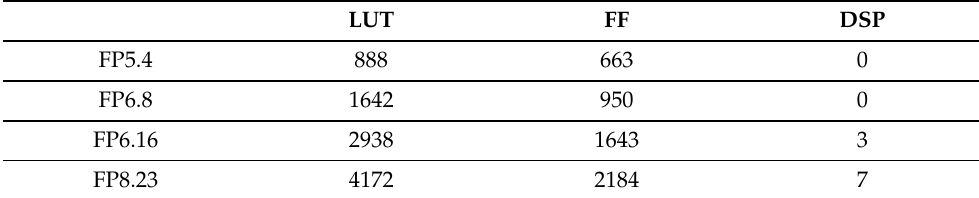
Table 4. Logic resources requirement for implementation of one ACSOM neuron with d = 3. LUT FF DSP